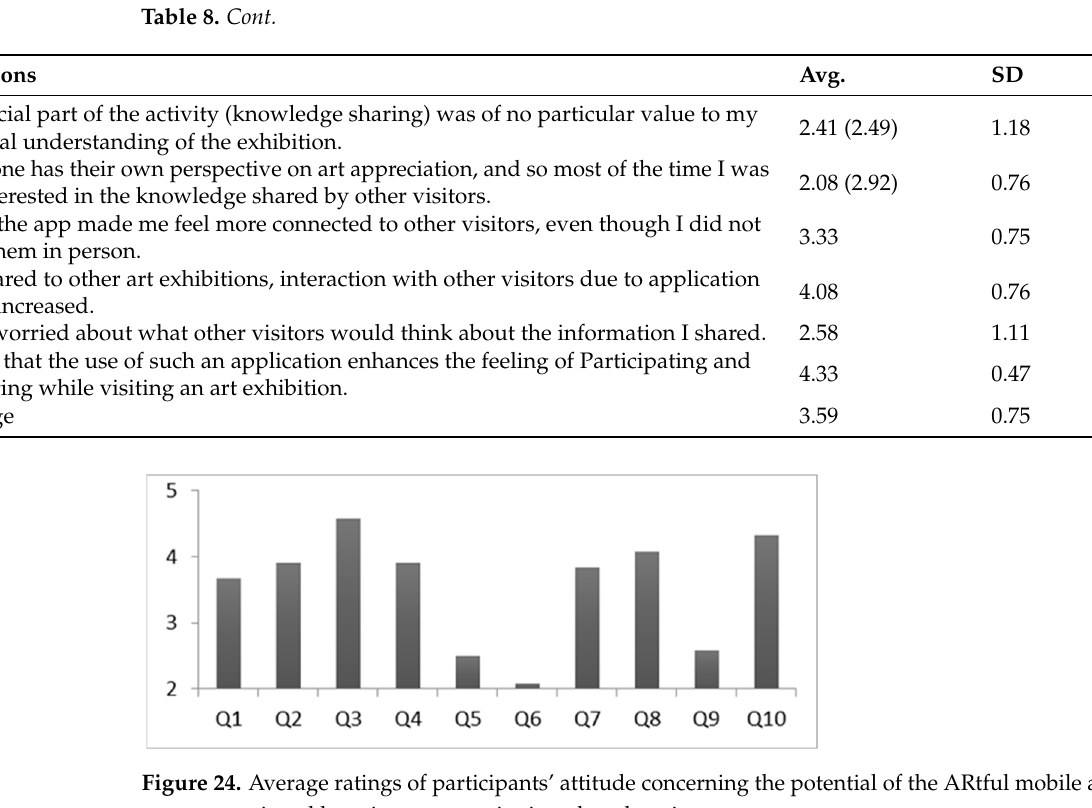
Table 9. Questions concerning the perceived performance of the ARtful mobile app.